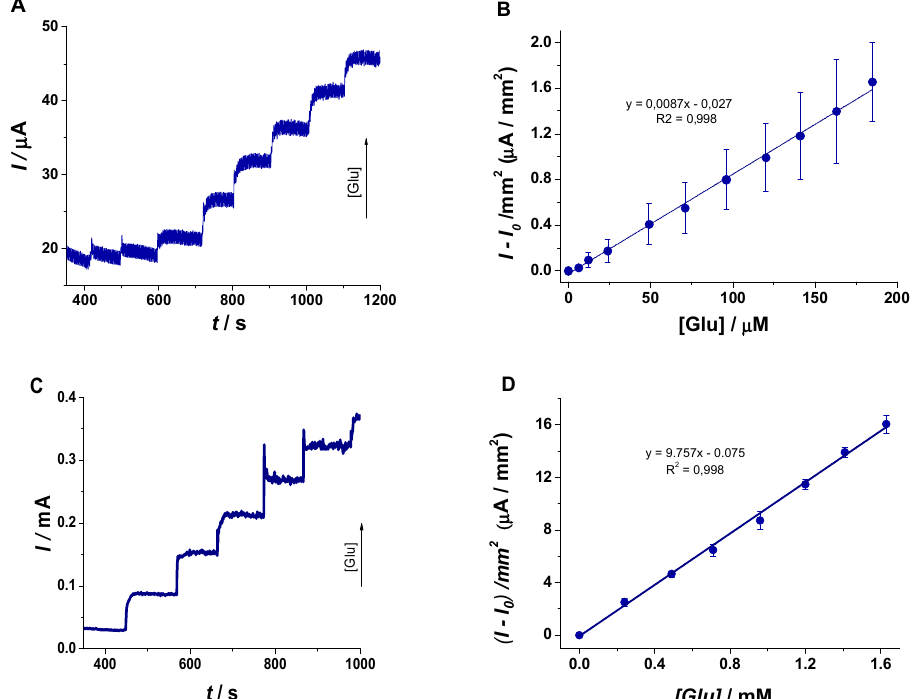
Figure 7. ( A ) CA of CuNi f electrodes in 0.1 M NaOH with standard additions of 2.5 mM Glu every 100 s (4 times of 12.5 µL to reach small concentration difference and then 25–50 µL until the end of analysis), under continuous stirring at 500 rpm (0.55 V, 0.1 s step potential, 1200 s analysis time); ( B ) the calibration curve in the range of 6–185 µM Glu; ( C ) CA of CuNi f electrodes in 0.1 M NaOH with standard additions of 25 mM Glu every 100 s of solution (50 µL) under continuous stirring at 500 rpm (0.55 V, 0.1 s step potential); ( D ) the calibration curve in the range of 0.24–1.63 mM Glu.